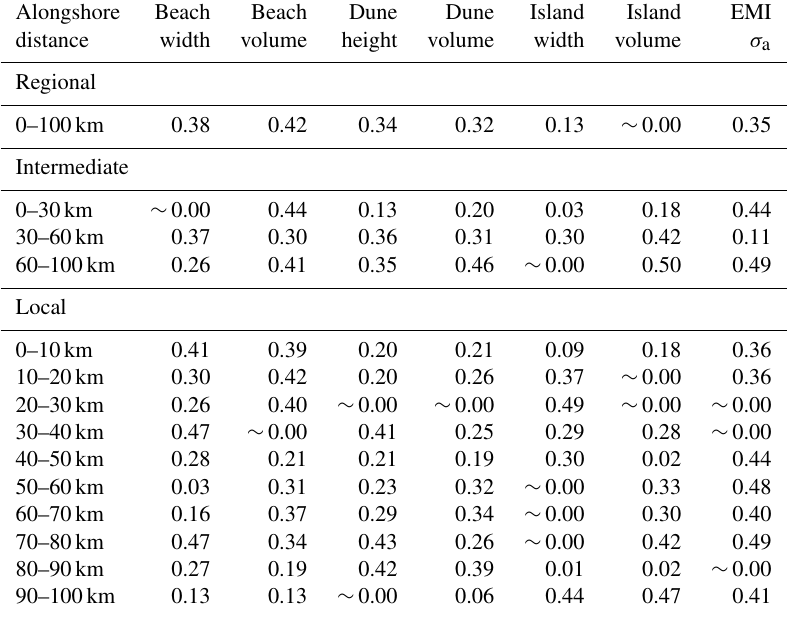
Table 3. Summary table showing the computed d parameters that most appropriately model each ARIMA (0 d 0) iteration (i.e., lowest RMSE). Alongshore Beach Beach Dune Dune Island Island distance width volume height volume